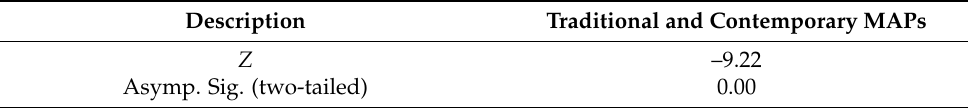
Table 4. Wilcoxon test: usage of traditional and contemporary